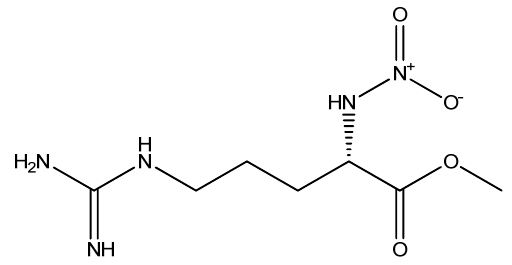
Figure 16. N -Nitro-L-arginine methyl